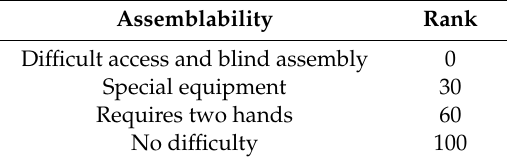
Table 11. Membership functions in tabular form of linguistic variables for